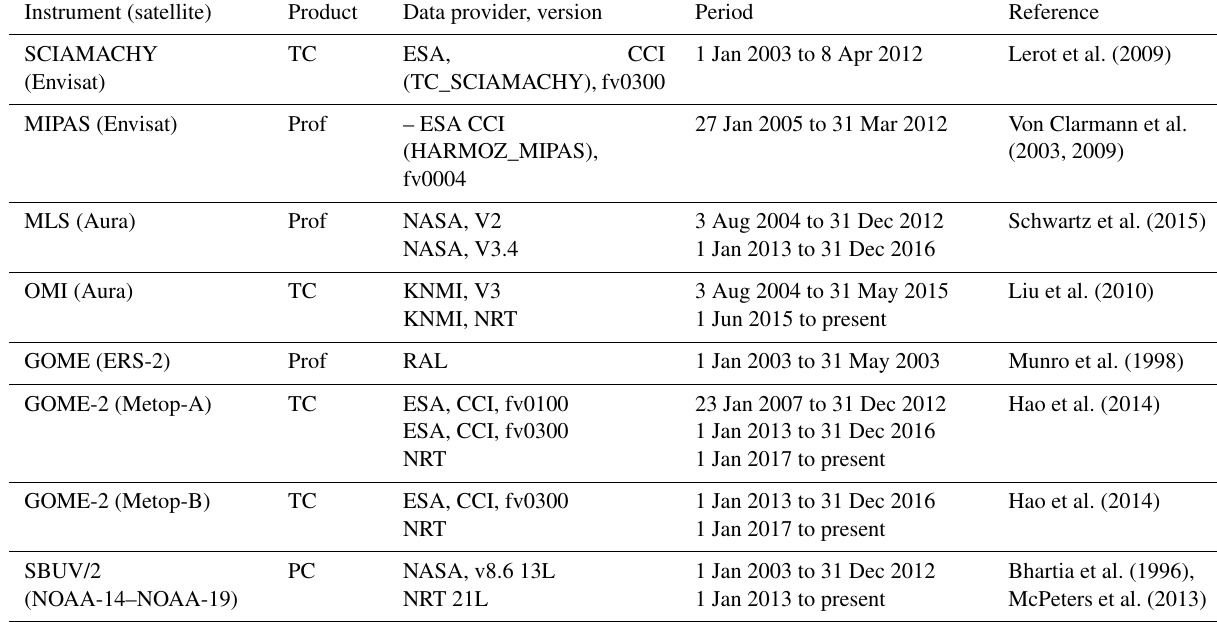
Table 2. Observations of ozone used in the CAMS-iRean assimilation system.